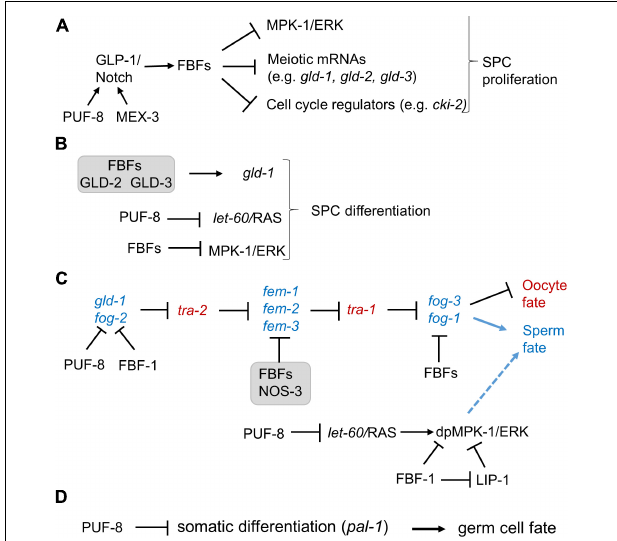
FIGURE 2 | The multiple functions of FBFs and PUF-8 in C. elegans germline SPCs. (A) PUF-8 acts redundantly with MEX-3 to facilitate GLP-1 signaling (Ariz et al., 2009). Downstream of GLP-1/Notch, FBFs promote germline SPC proliferation by repressing cell cycle regulators, meiotic mRNAs, and mpk-1 MAP kinase (Crittenden et al., 2002; Lee et al., 2007a; Kalchhauser et al., 2011). (B) FBFs act with GLD-2, GLD-3 complex to promote SPC meiosis by activating GLD-1 expression (Suh et al., 2009). PUF-8 facilitates meiosis by repressing LET-60/RAS (Vaid et al., 2013), while FBFs repress mpk-1 . The contribution of mpk-1 repression by FBFs to regulation of SPC proliferation and differentiation is discussed in section “PUF Function in Inhibiting Mitotic Cell Fate of SPCs and Promoting Differentiation.” (C) PUF-8 controls the sperm/oocyte switch by acting redundantly with FBF-1 to repress fog-2 (Bachorik and Kimble, 2005). FBF proteins control the sperm/oocyte switch by acting with NOS-3 to repress fem-3 (Kraemer et al., 1999; Arur et al., 2011) as well as by repressing fog-1 and possibly fog-3 (Thompson et al., 2005). Both PUF-8 and FBF-1 cooperate with LIP-1 to repress MPK-1 activity in SPCs, dpMPK-1 refers to a diphosphorylated active form of MPK-1 (discussion and references in section “PUF Function in Controlling the Sperm/Oocyte Decision in Germline Mitotic Zone”). dpMPK-1 promotes spermatogenesis, although specific relevant substrates are yet unknown. (D) PUF-8 maintains germ cell fate by repressing somatic transcription factor PAL-1 (Mainpal et al.,